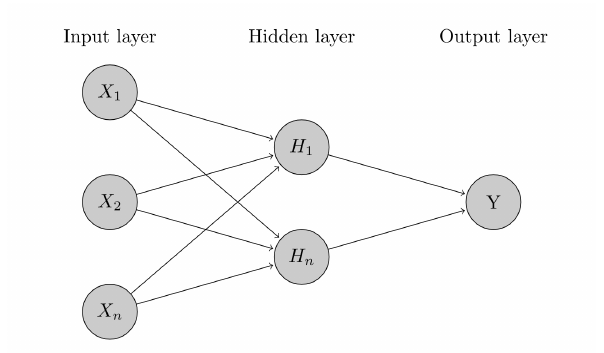
Figure 4. General scheme for Artificial Neural Network